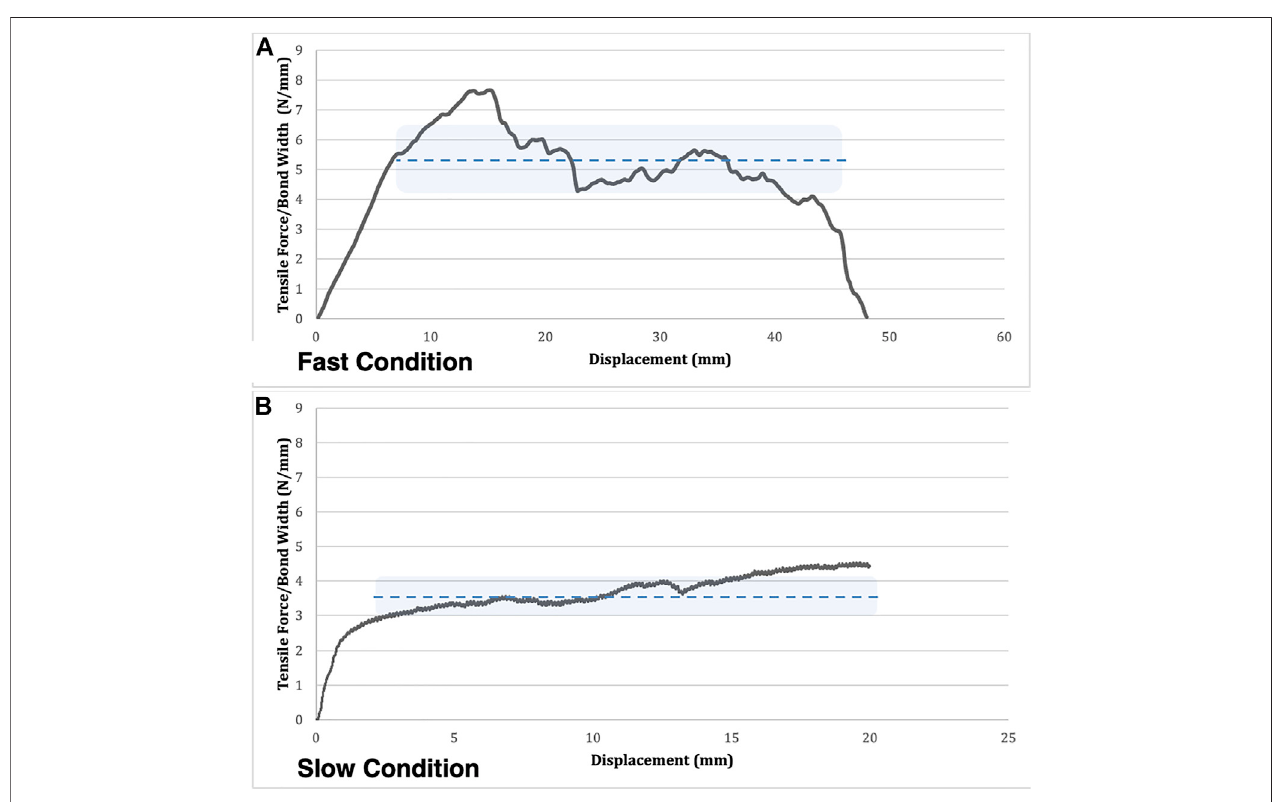
FIGURE 4 | A comparison of a typical adhesion-strength curve for a fast (A) and slow (B) condition trial. Mean lamellar adhesion strength is represented by the dotted line. The lamellar adhesion strength variability is represented by the shaded area above and below the line of the mean. Note the higher variability across the plateau in the fast condition compared to the slow condition.